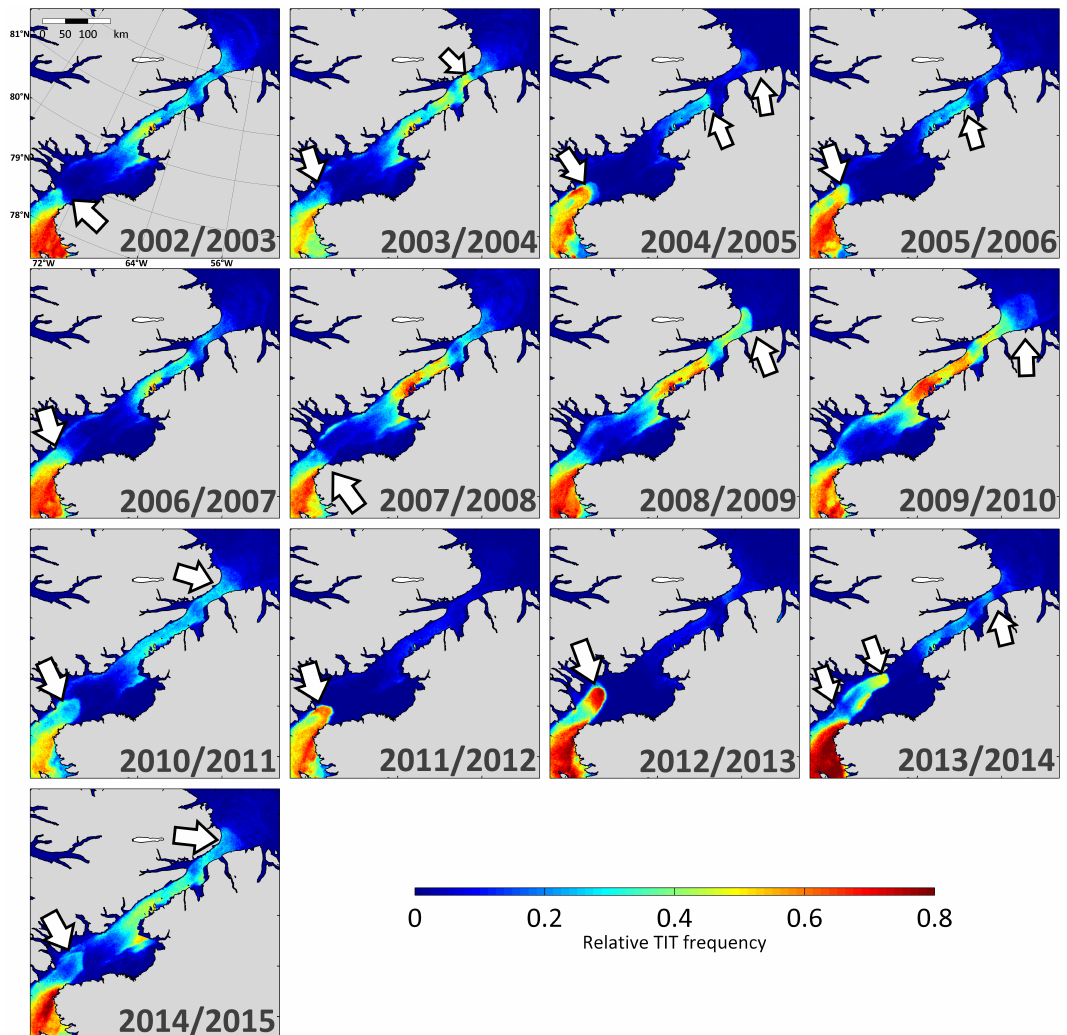
Figure 11. Relative frequency distribution of thin-ice thickness ď 0.2 m in northern Baffin Bay/Smith Sound, Nares Strait and Lincoln Sea for the complete freezing seasons (November to March) 2002/2003 to 2014/2015, based on daily TIT composites. Observed sites of ice bridge appearances between November and March are indicated by white